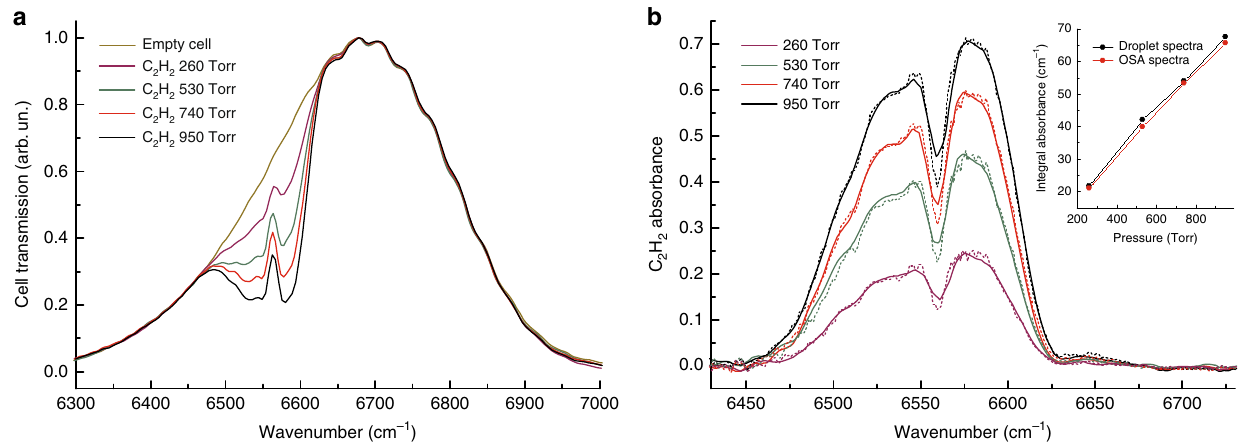
Fig. 3 Acetylene absorption. a transmission spectrum of a spontaneous emission source through an acetylene cell at different pressures (droplet spectrometer, Fourier transform settings as in the spectrum of Fig. 2); b acetylene absorbance curves obtained by off-line normalization of the spectra shown in panel a to the empty-cell transmission; dashed lines: same absorbance curves as measured by a commercial optical spectrum analyzer (8.5 cm − 1 resolution, 3-points adjacent averaging); inset: integral absorbance values calculated from the described